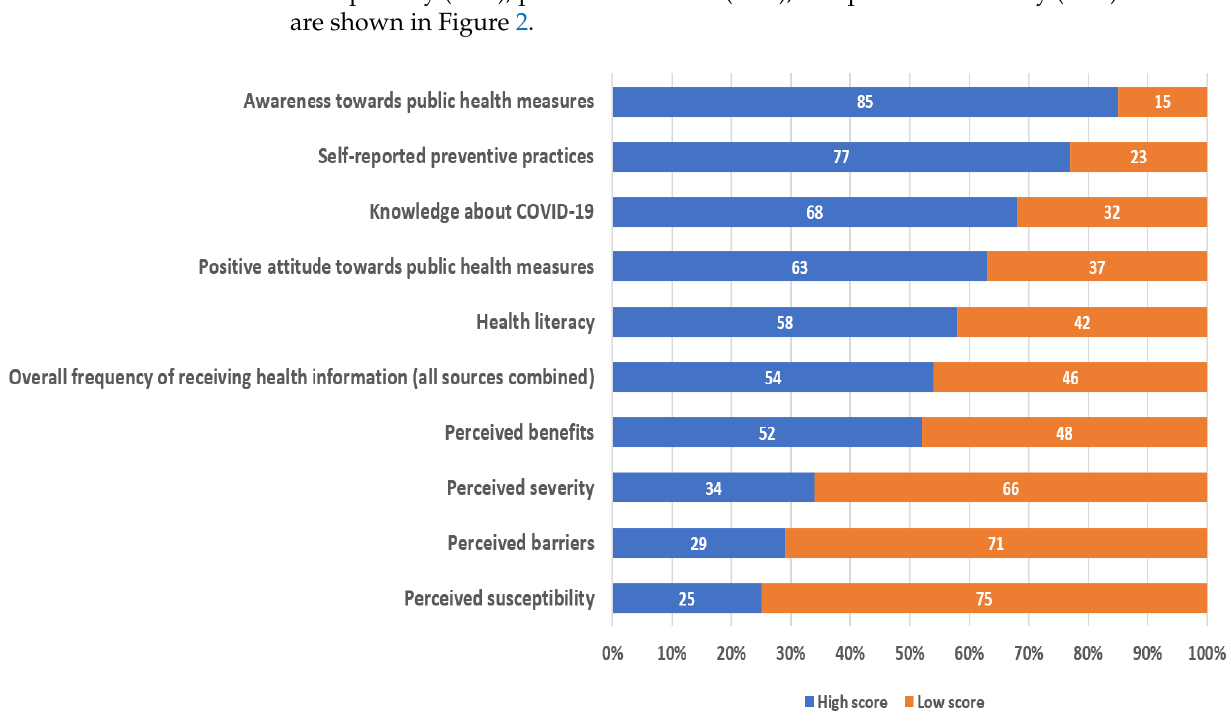
Figure 2. Proportion of scores for the variables.